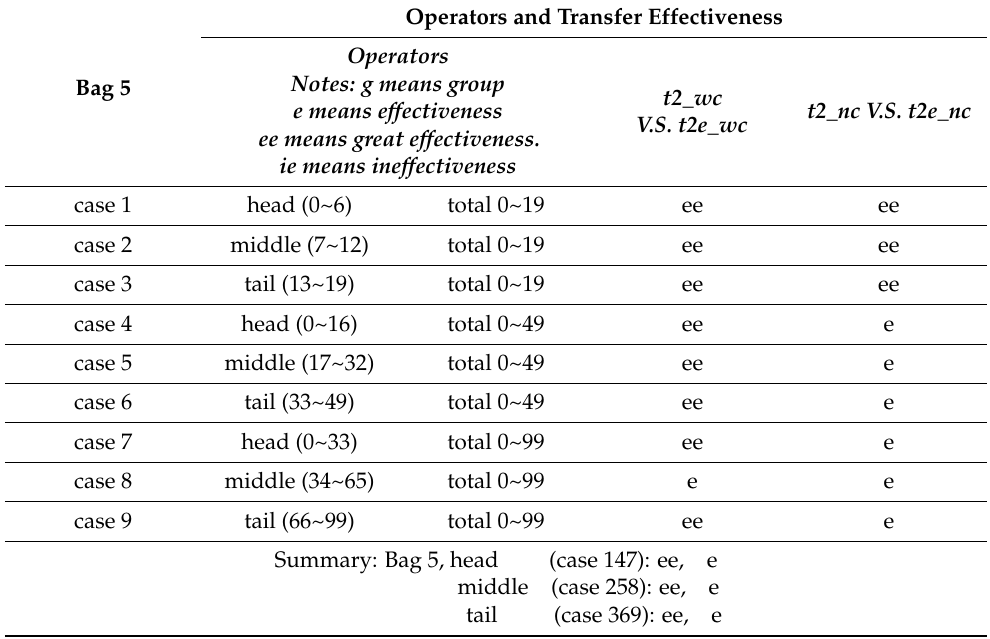
Table 1. Comparisons in Bag 5 for ETO_PFSP